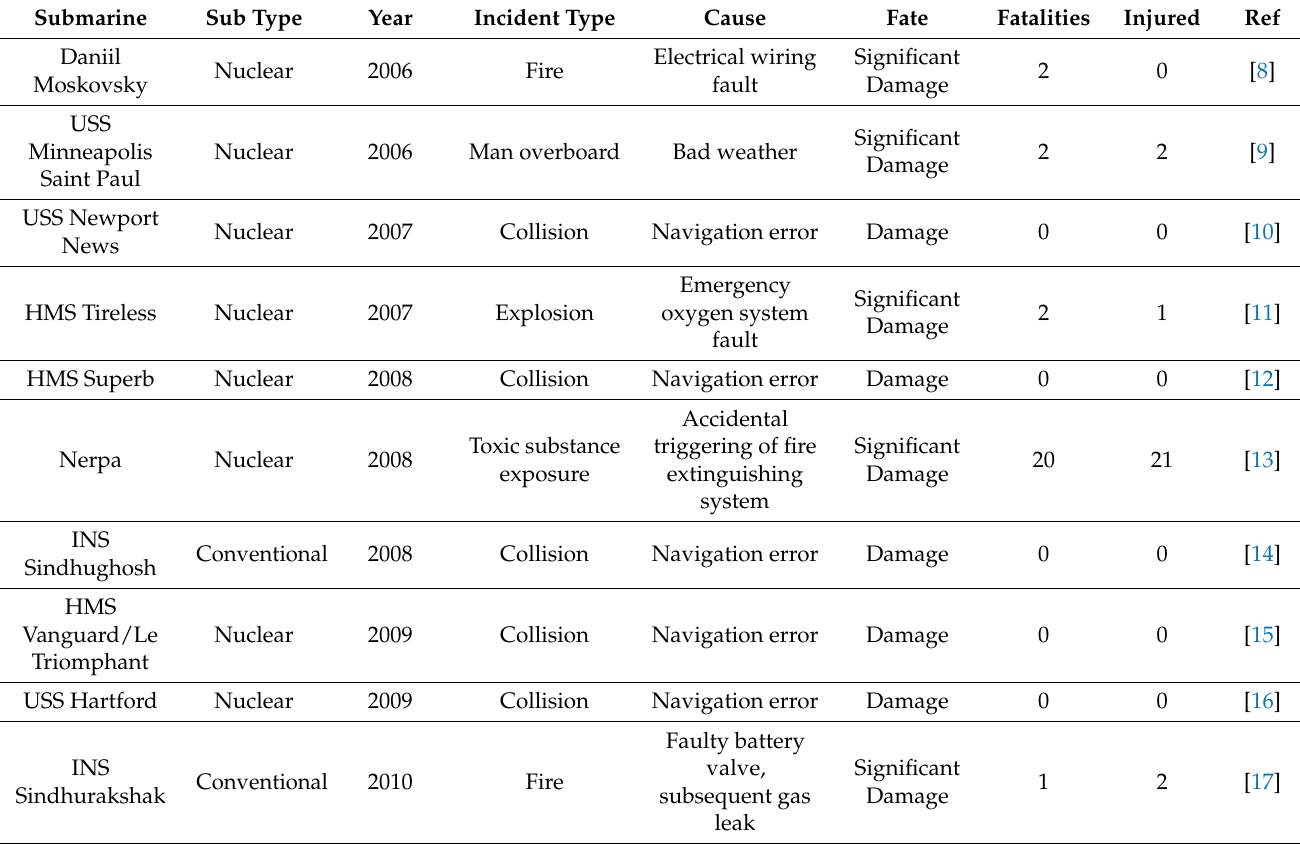
Figure 1. Relative Contribution of Submarine Incident Types, 1946 to 2005 [7]. Table 1. Publicly Reported Submarine Incident Listing,